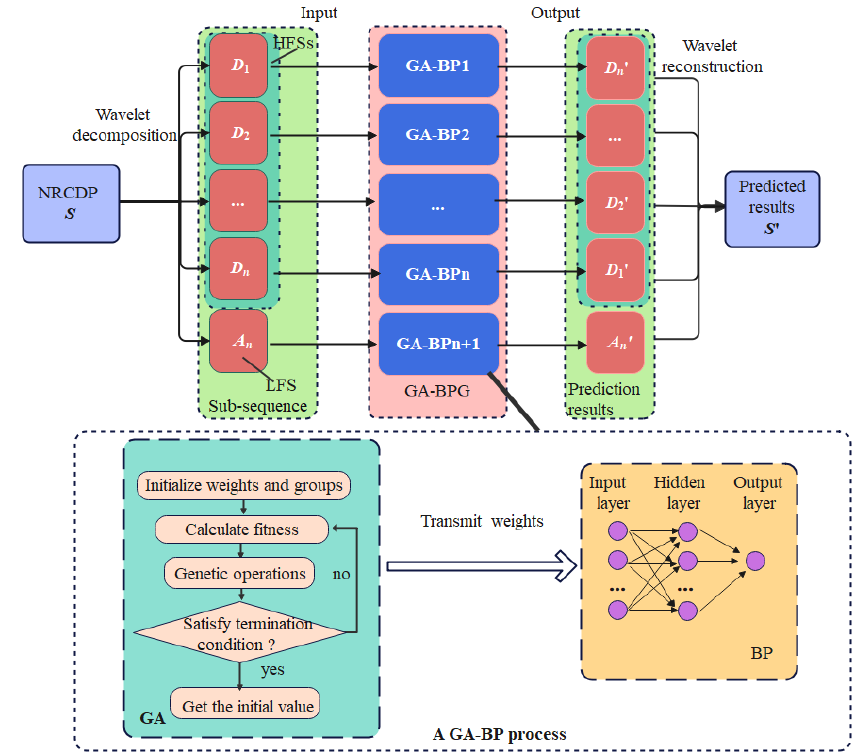
Figure 5. Process of W-GA-BPG algorithm.